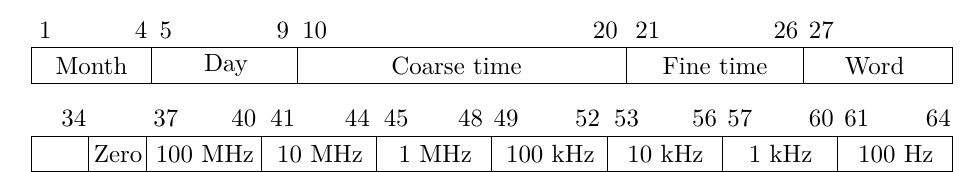
Figure 6: Tweak format for HALFLOOP as used in 2G and 3G ALE. The coarse time field holds minutes since midnight and the fine time fields holds seconds in the current minute. The four bit frequency fields are used to encode the frequency as a binary coded decimal number. Bits 35 and 36 are always